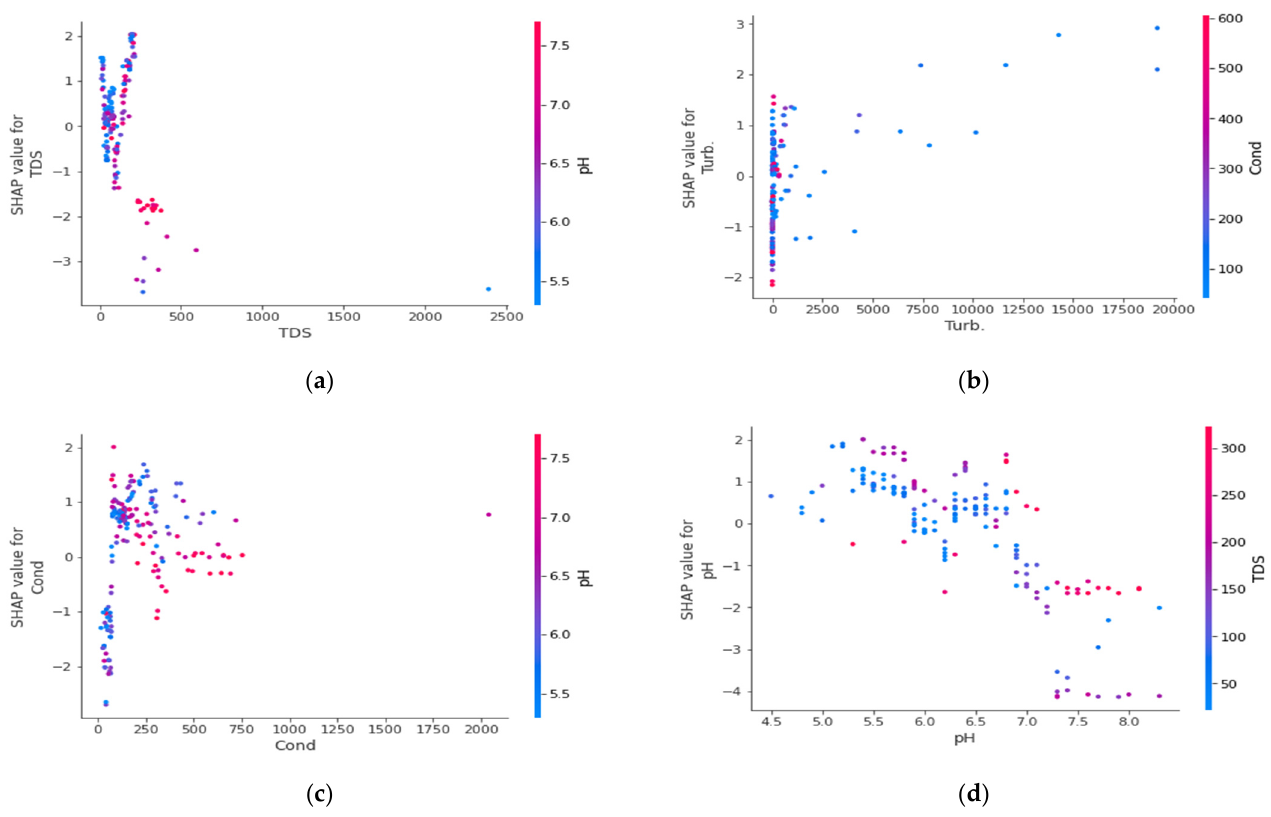
Figure 9. SHAP dependency and interaction effect plots for low As concentrations: ( a ) TDS; ( b )Turb; ( c ) Cond; and ( d ) pH.